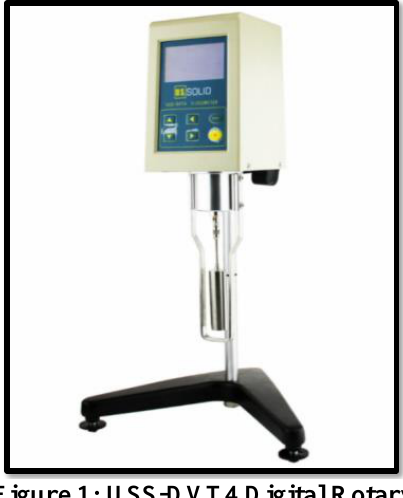
Figure 1: USS-DVT4 Digital Rotary Viscometer Table 1: The effect of DM on physical